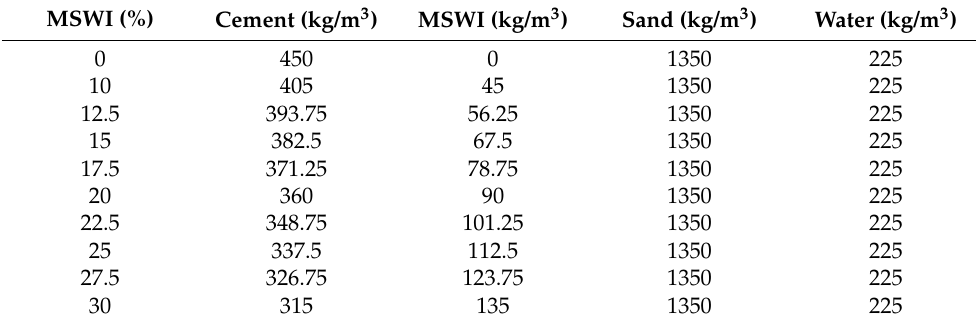
Table 2. Mix proportion of MSWI mortar.